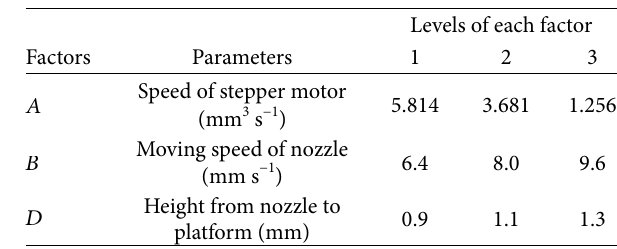
Table 2: Factors and level of the orthogonal experiment.